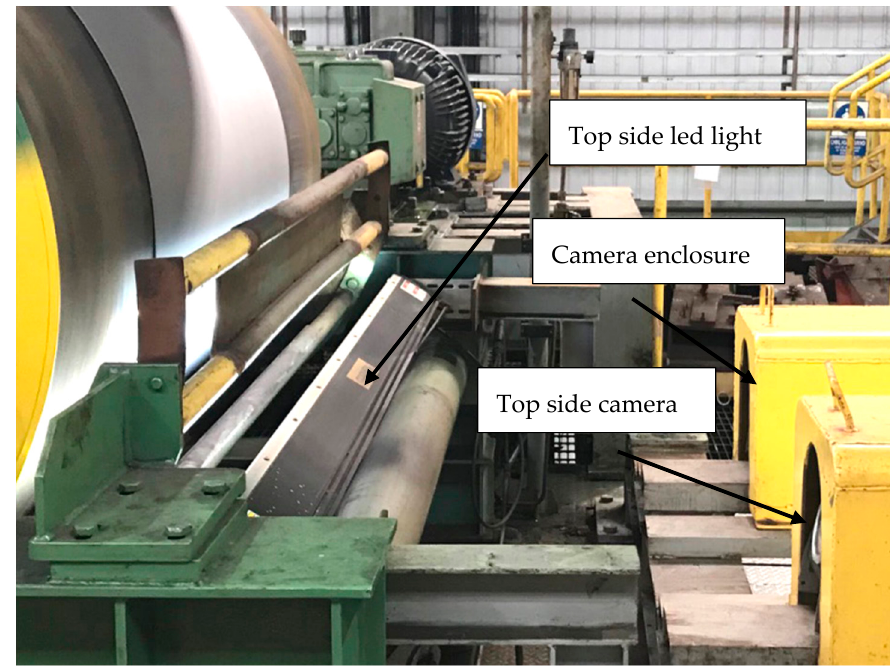
Figure 6. The SmartView system at the end of pickling line.